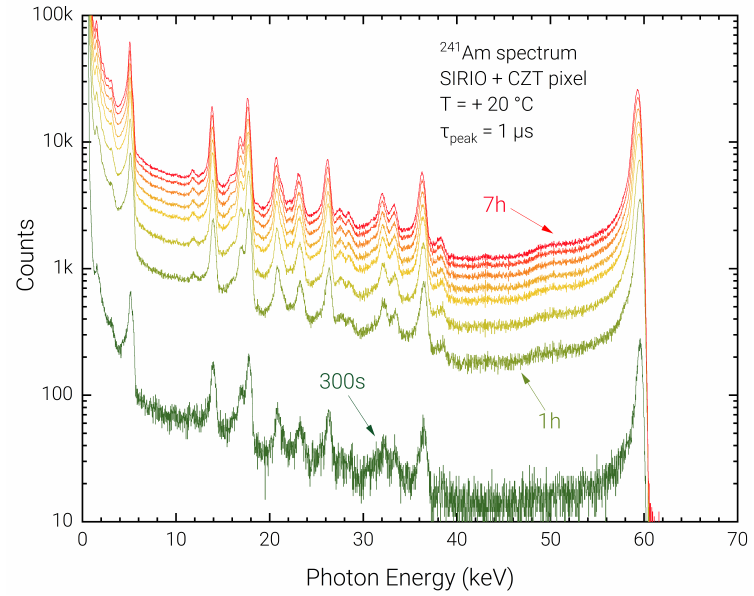
Figure 8. Room temperature energy spectra acquired in a 7-h measurement session, with 1-h acquisi- tion